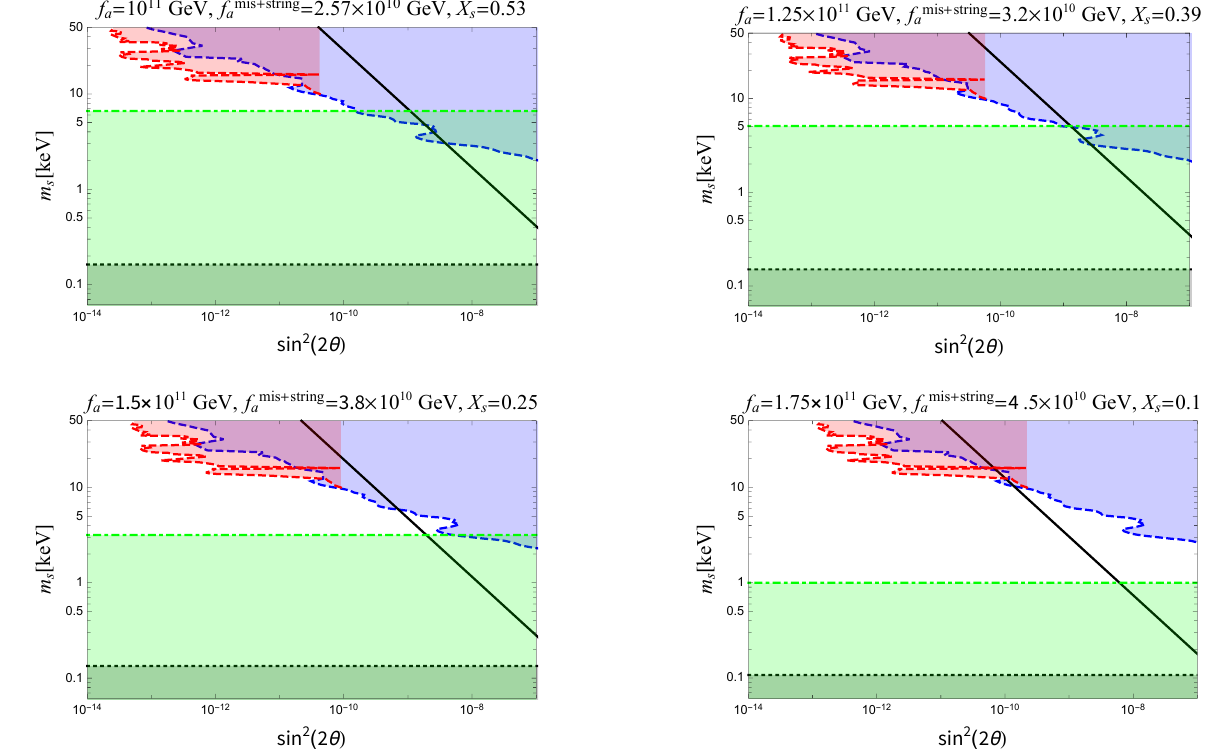
Figure 6. The non-resonant sterile neutrino (black solid lines) and the X-ray and phase-space bounds of Figure 5 together with the structure formation bounds of Section 4.1 (dash-dotted